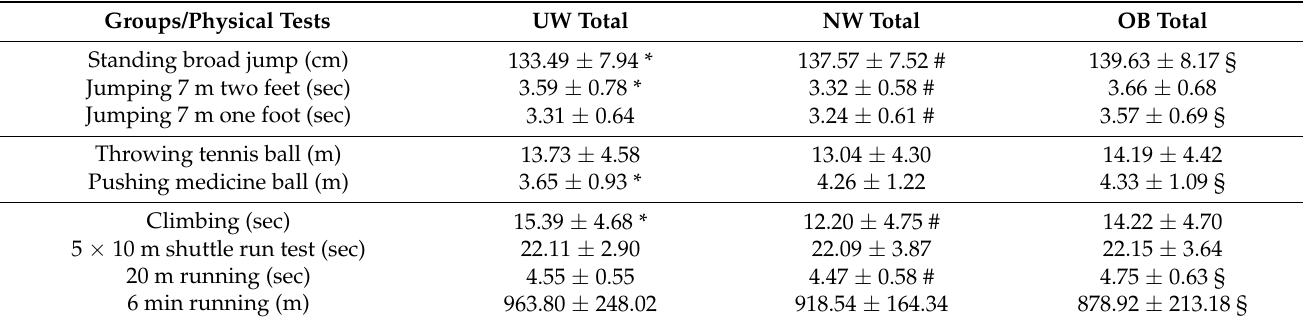
Table 2. Differences between groups in the physical fitness tests.